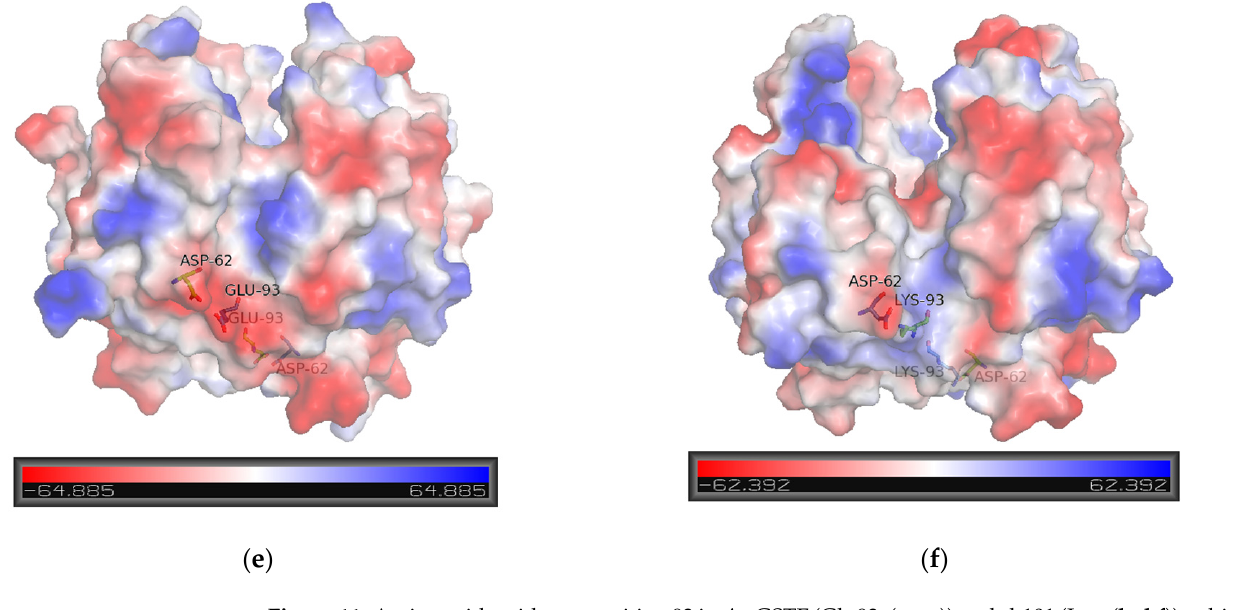
Figure 11. Amino acid residue at position 93 in Am GSTF (Glu93; ( a , c , e )) and sh101 (Lys; ( b , d , f )), which is involved in the formation of a new salt bridge with Asp62 of the opposite subunit. ( e , f ) Electrostatic surface of the dimers is depicted with 50% transparency. The figures were created with PyMol [61].